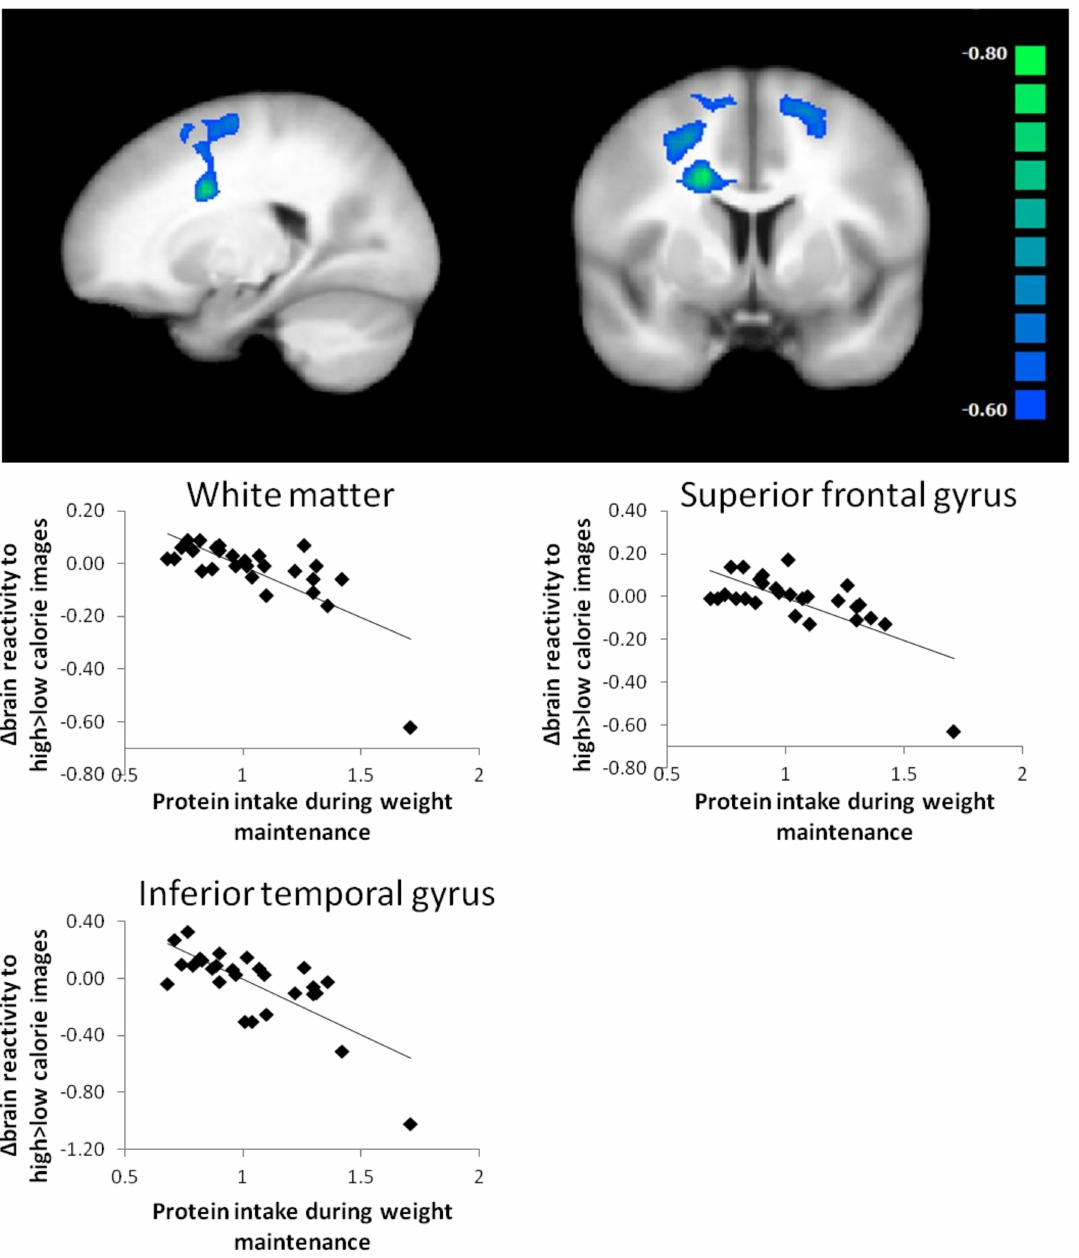
Figure 2. Whole brain contrast map of brain regions with significant inverse associations between changes in high > low calorie images brain activation and daily protein intake (g/kg) during weight maintenance. Inverse associations are shown in blue ( p < 0.005, corrected for multiple comparisons). Scatter plots of protein intake and changes in extracted high > low calorie images BOLD response are shown